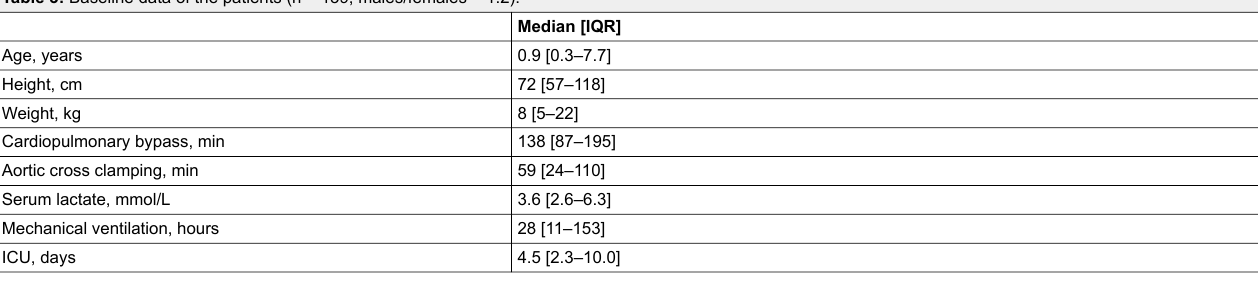
Table 4: Sensitivity, specifity and accuracy for the patient cohort at the optimal serum Cystatin C and urine NGAL concentration.